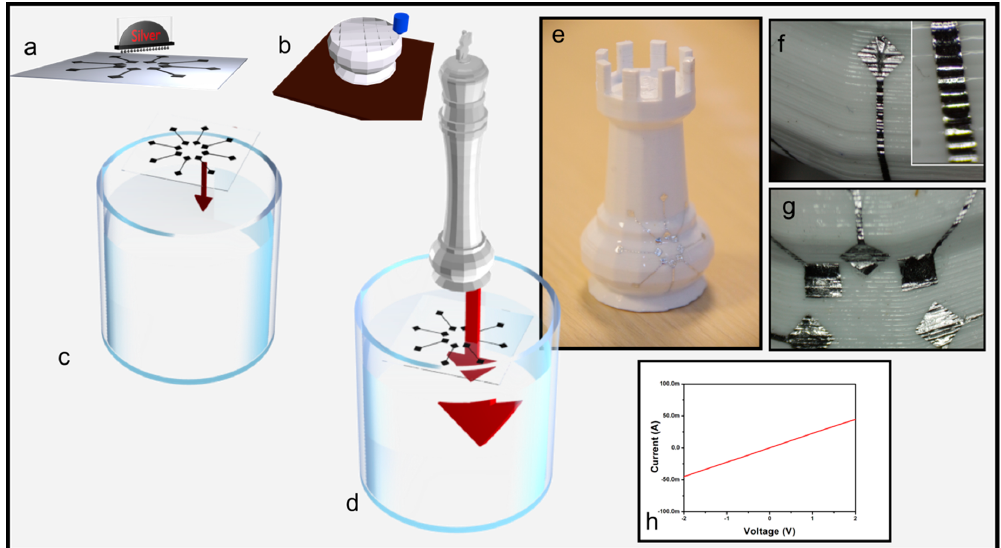
Figure 3. Water Transfer printing technology. 3D schemes showing: ( a ) interconnects printed on water soluble substrate; ( b ) daily life 3D object additively fabricated using FDM; ( c ) PVA substrate deposited on top of water, ( d ) 3D object dipped through floating interconnects; optical pictures showing: ( e ) a chess piece decorated with metallic ribbons arranged in star configurations; ( f ) metallic ribbon wrapping a convex part of the 3D object; ( g ) metallic patterns wrapping a concave part of the 3D object; ( h ) I(V) curve.